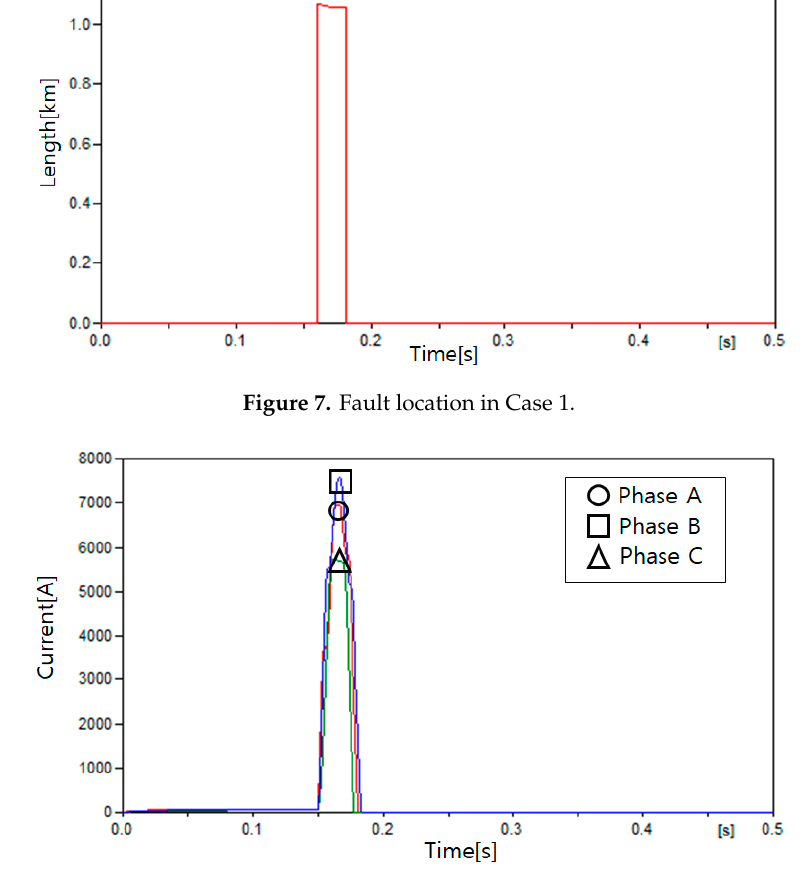
Figure 8. Current waveform measured at I 1 in Case 1.